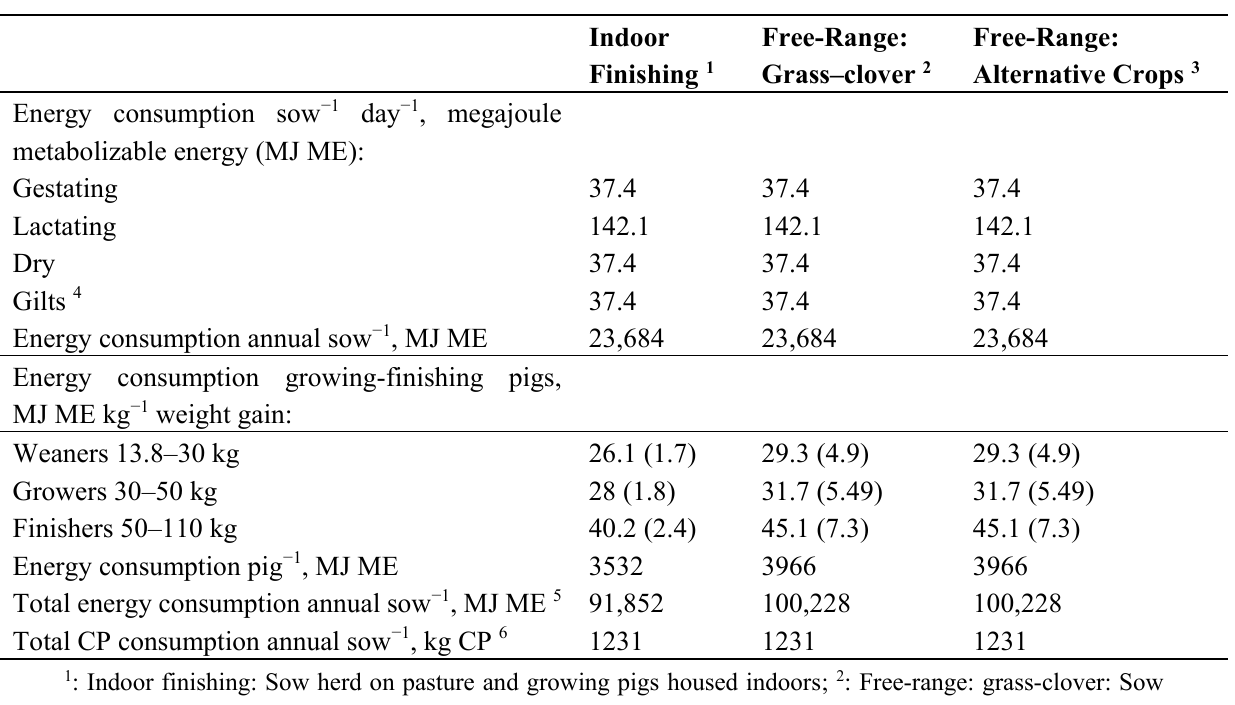
Indoor Finishing 1